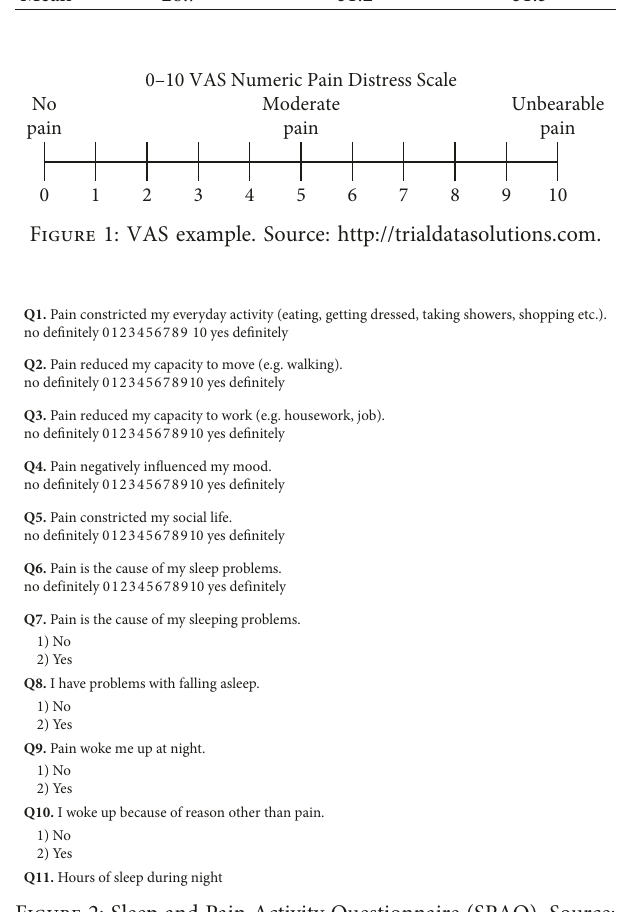
Figure 2: Sleep and Pain Activity Questionnaire (SPAQ). Source: